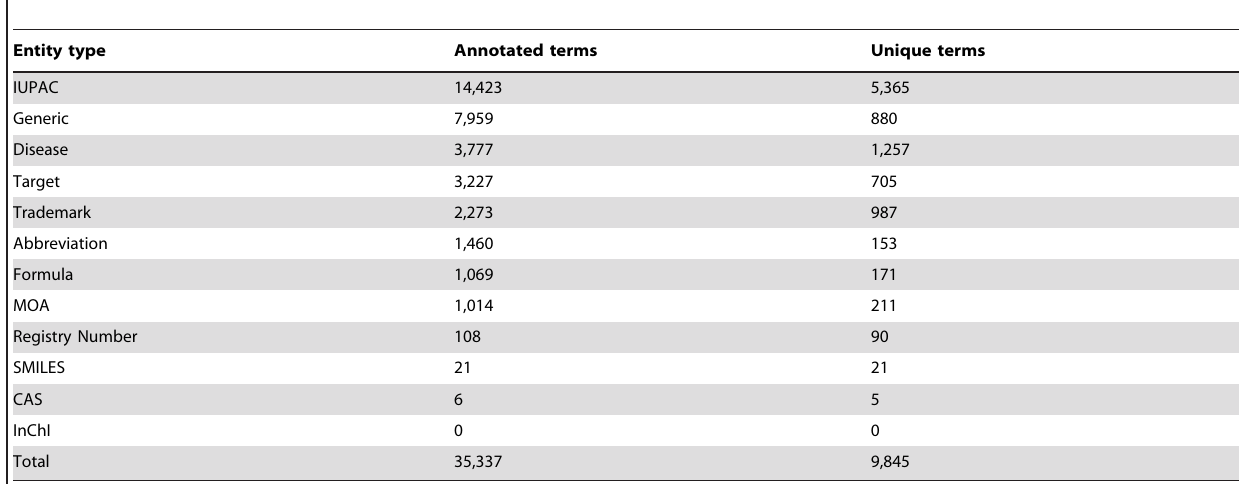
Table 2. Number of annotated terms and unique terms within the harmonized set prior to disambiguation.